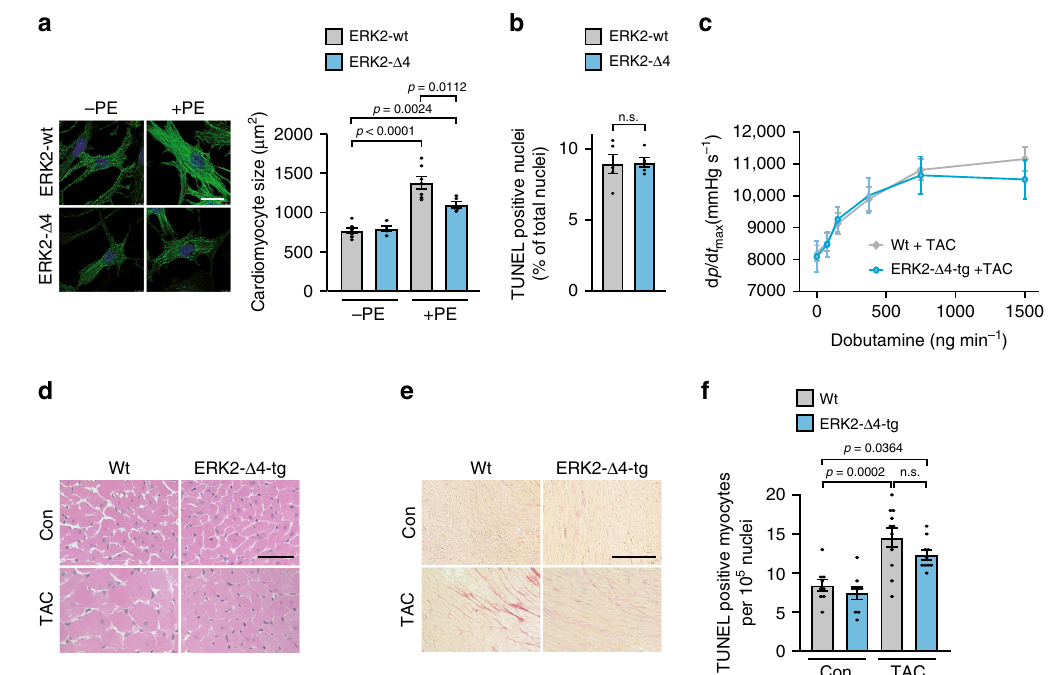
Fig. 1 Monomeric ERK2 Δ 174 – 177 reduces cardiac hypertrophy but not cell survival. a , b Analyses of cardiomyocyte size and apoptosis. Neonatal rat cardiomyocytes (NRCM) were transduced with Flag-tagged ERK2 wild-type (ERK2-wt) or the Flag-tagged monomeric ERK2 mutant, Flag-ERK2 Δ 174 – 177 (ERK2- Δ 4), and treated with phenylephrine (PE, 4 µ M, 24 h; a ) or hydrogen peroxide (H 2 O 2 , 100 µ M, 1 h; b ) as indicated. a Representative phalloidin- stained NRCM (scale bar 20 µ m) and analysis of cell size (ERK2-wt, n = 7; ERK2- Δ 4, n = 5, 50 – 70 cells per group and experiment). b Analysis of TUNEL- positive NRCM ( n = 5 and 500 – 1000 cells per group and experiment). c – f Analyses of cardiac function, cardiomyocyte size, interstitial fi brosis, and apoptosis of wild-type mice (Wt) and mice with cardiac-speci fi c overexpression of ERK2 Δ 174 – 177 (ERK2- Δ 4-tg). Mice were analyzed either untreated at the age of 8 weeks (Con) or 6 weeks after subjection to transverse aortic constriction (TAC). c Speed of left ventricular pressure rise (d p /d t max ) determined by left ventricular cardiac catheterization in response to dobutamine (Wt + TAC, n = 13; ERK2- Δ 4-tg + TAC, n = 8 mice); d , e representative histological H&E (scale bar 50 µ m, d ) and Sirius Red (scale bar 200 µ m, e )-stained sections of left ventricular myocardium, quanti fi cation in Supplementary Table 1; f analysis of TUNEL-positive cardiomyocyte nuclei (Con, n = 9; ERK2- Δ 4-tg, n = 9; Wt + TAC, n = 11; ERK2- Δ 4-tg + TAC, n = 10 mice per group. Error bars are mean ± s.e.m. For statistical analysis ordinary one-way ANOVA and Bonferroni as post hoc test ( a , c , f ) or unpaired two-sided Student ’ s t -test ( b ) were applied. n numbers in a and b represent biologically independent experiments. Source data are provided as a Source Data fi